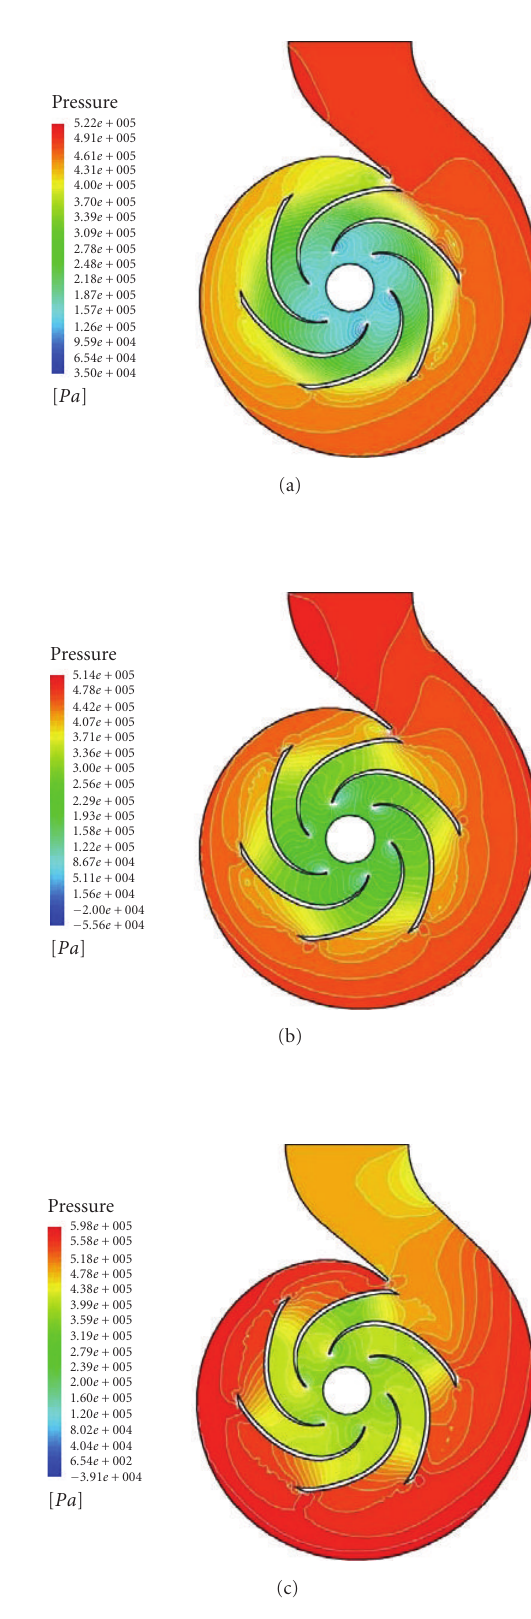
Figure 8: Pressure distribution inside impeller and volute. (a) O ff - design point, Q = 0.43 Q design . (b) Design point, Q design . (c) O ff - design point, Q = 1.45 Q design